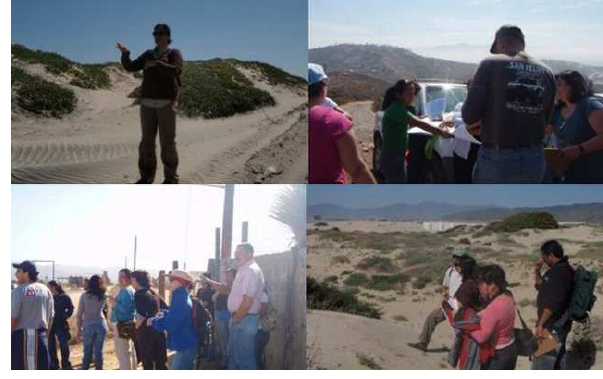
Fig. 8. The Municipal Planning and Research Institute